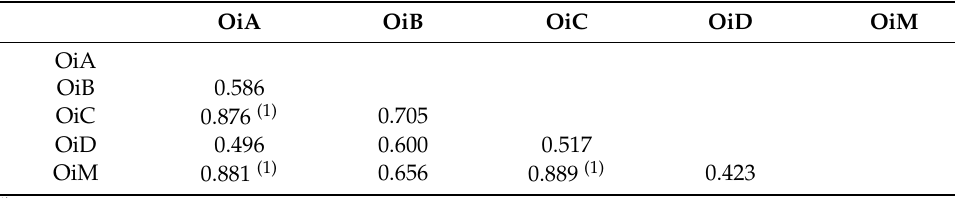
Table 5. Discriminant validity assessment of the second-order constructs using the HTMT ratio. OiA